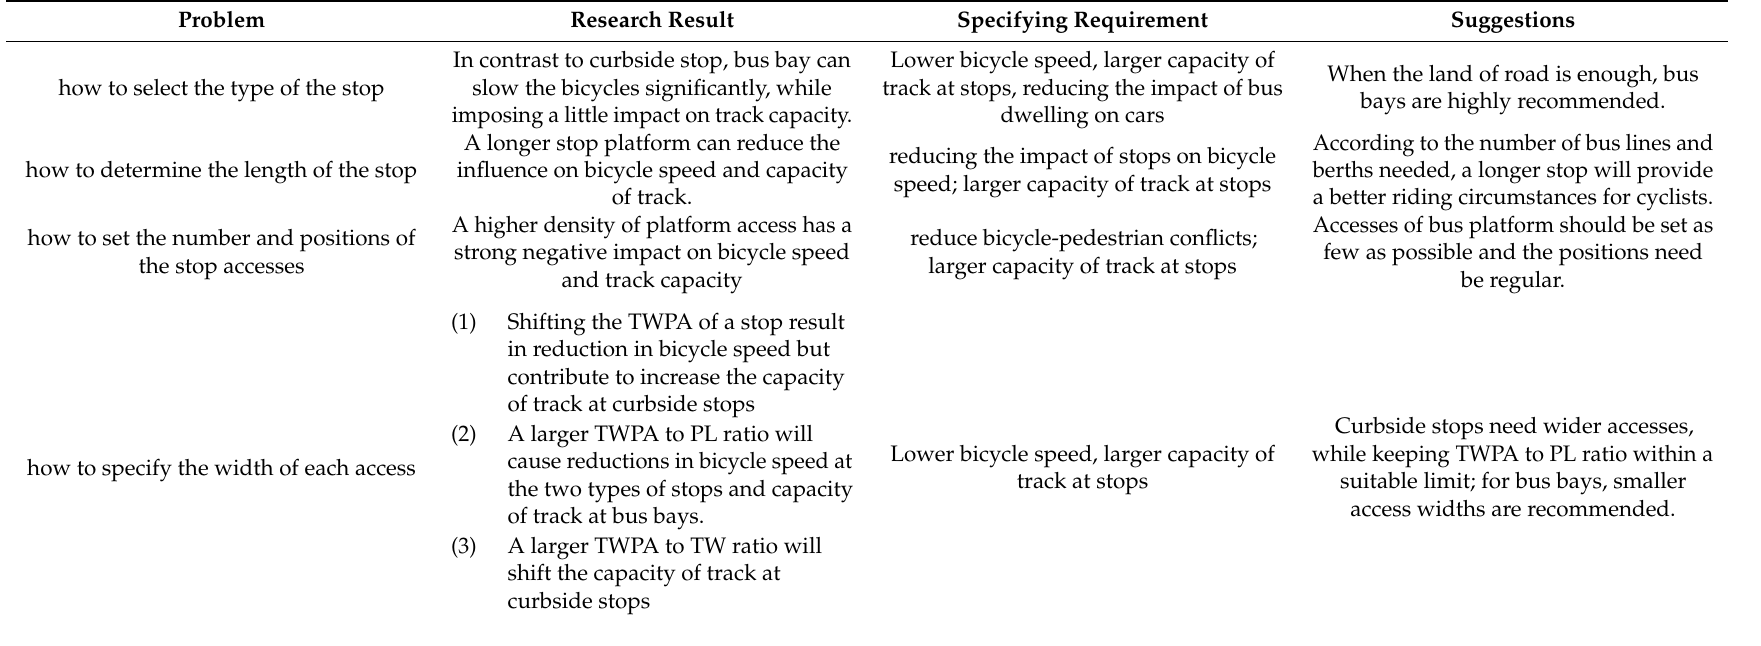
Table 5. Suggestions for Specifications of Bus